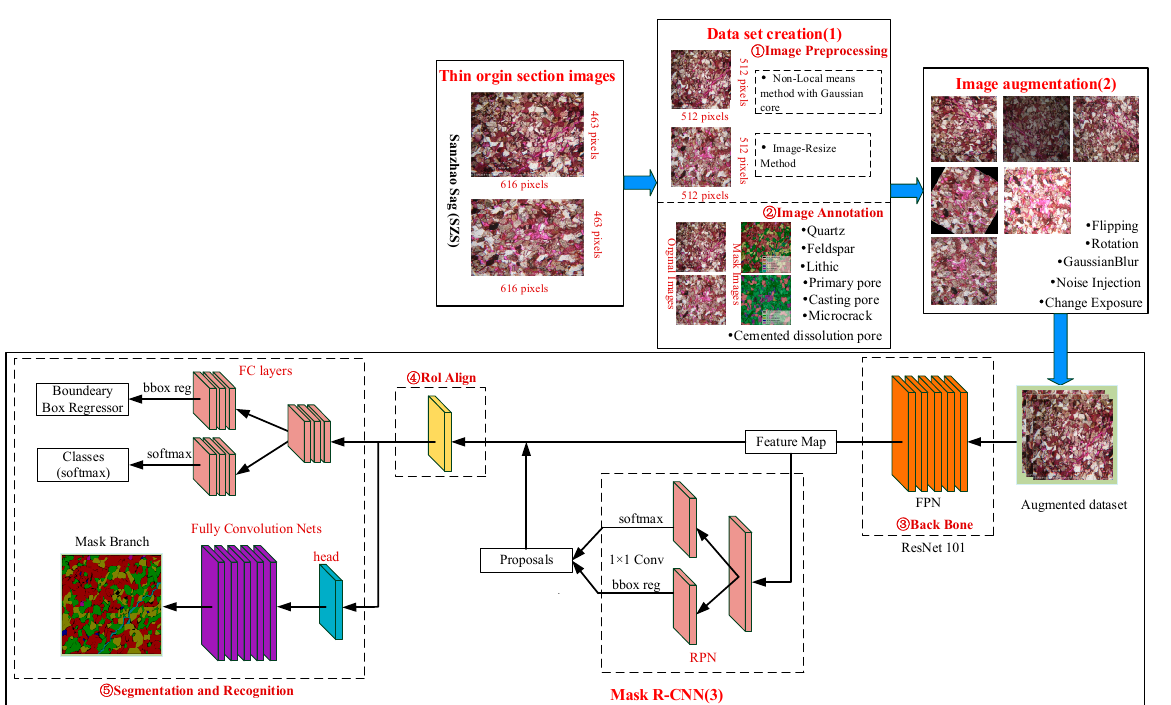
Figure 1. SMR Method Process.